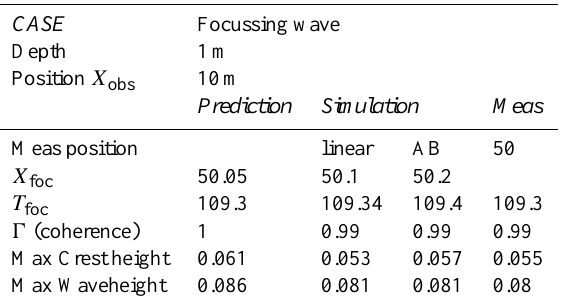
Table 1. Parameters for the dispersive focussing